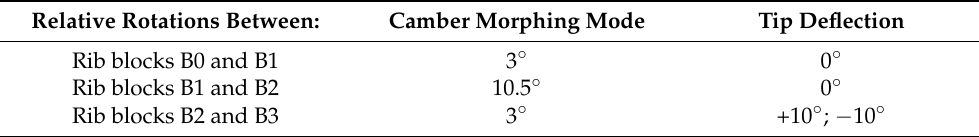
Table 3. Relative rotations between rib blocks (design values).